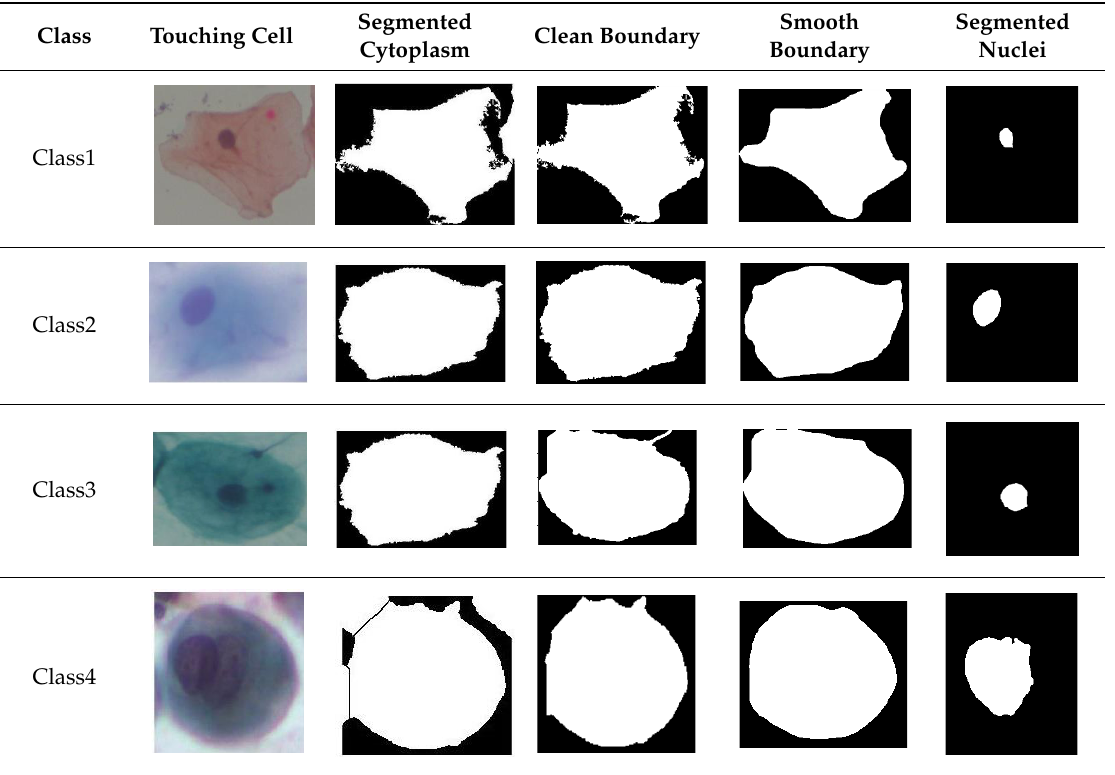
Table 8. Nuclei and Cytoplasm Segmentation for touching cells.